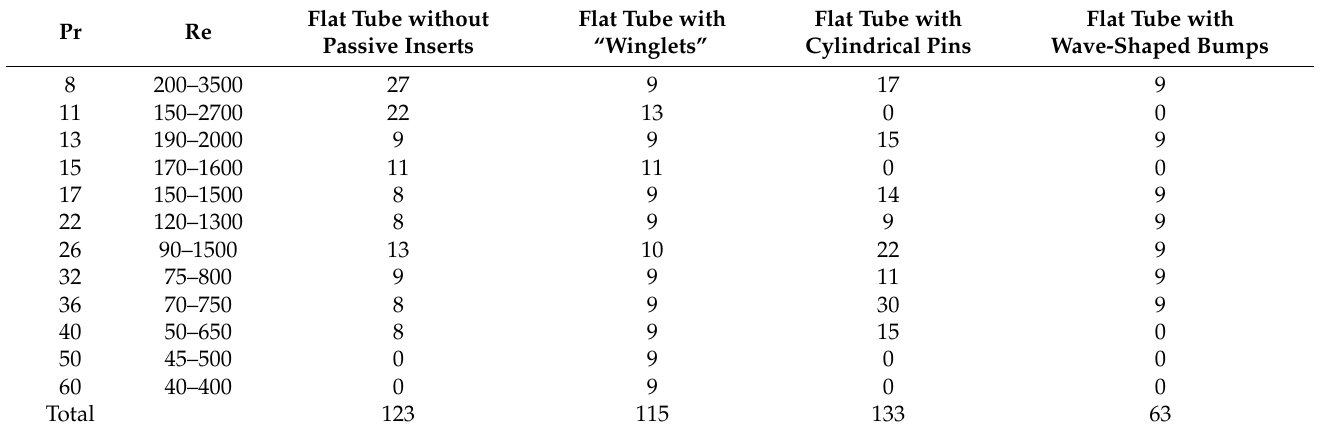
Table 3. Amount of test data for specific Prandtl and Reynolds number